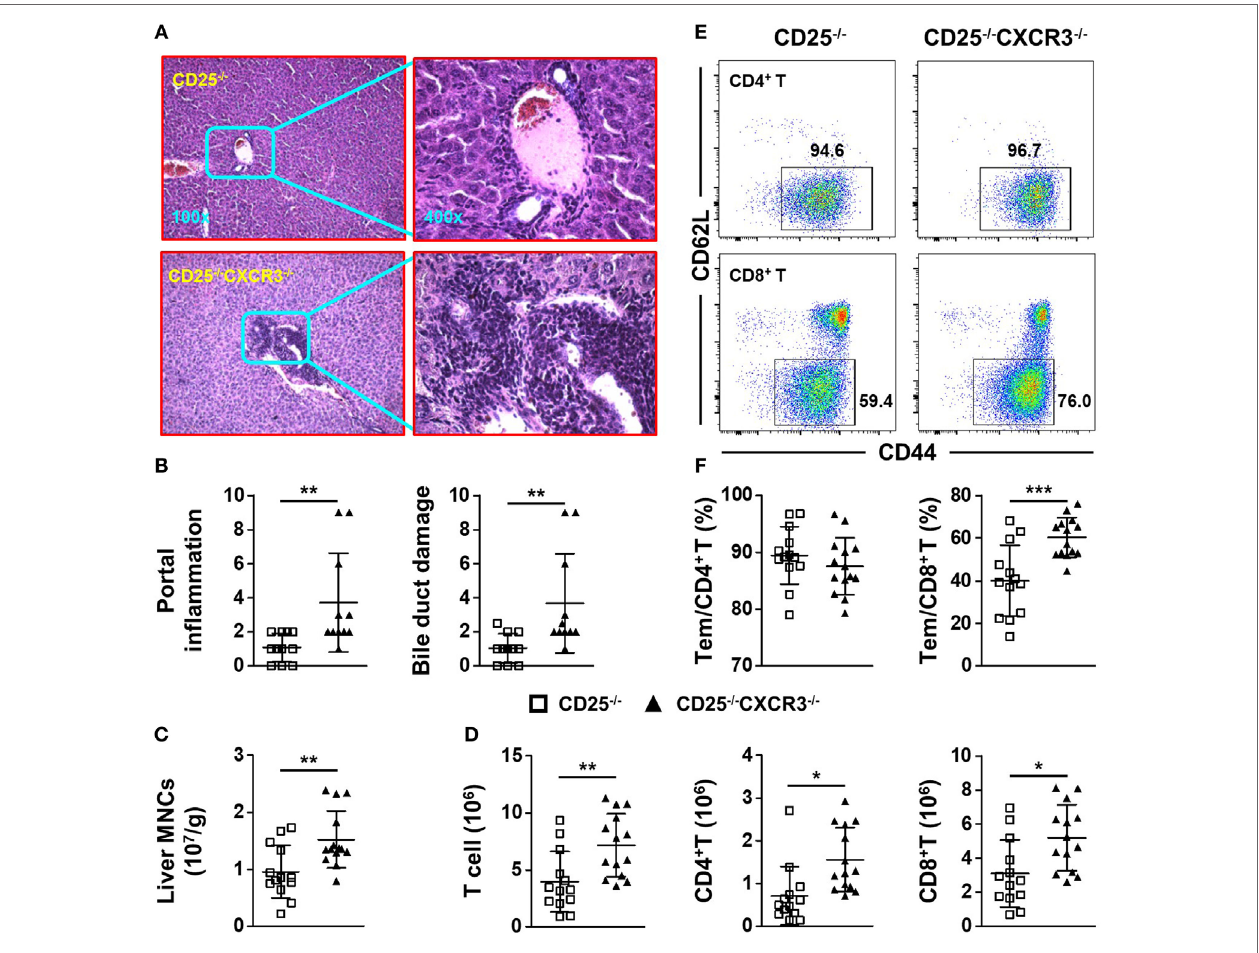
FigUre 3 | CXC chemokine receptor 3 (CXCR3) deletion aggravates liver inflammation of CD25 − / − mice. (a) Representative H&E-stained liver sections of CD25 − / − and CD25 − / − CXCR3 − / − mice at the original magnification of 100 × and 400 × . (B) Scores of portal inflammation and bile duct damage in CD25 − / − mice ( N = 11) and CD25 − / − CXCR3 − / − mice ( N = 11). (c) Numbers of liver mononuclear cells (MNCs) per gram of liver weight in CD25 − / − mice ( N = 13) and CD25 − / − CXCR3 − / − mice ( N = 14). (D) Numbers of liver T, CD4 + T, and CD8 + T cells from CD25 − / − mice ( N = 13) and CD25 − / − CXCR3 − / − mice ( N = 14). (e) Representative flow cytometry dot plots of CD44 and CD62L expression on CD4 + T and CD8 + T cells from CD25 − / − mice and CD25 − / − CXCR3 − / − mice. (F) Percentages of effector memory (Tem) cells in hepatic CD4 + T and CD8 + T populations of CD25 − / − mice ( N = 13) and CD25 − / − CXCR3 − / − mice ( N = 14). * p < 0.05; ** p < 0.01; *** p <